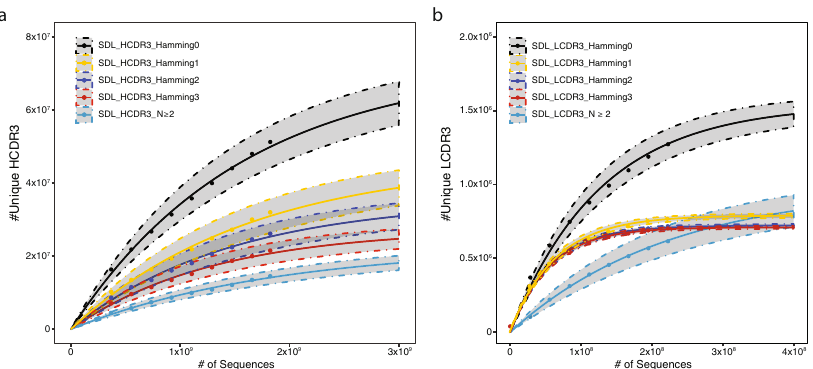
Fig. 2 Heavy and light chain diversity accumulation curves. a Species accumulation curves for HCDR3 at varying hamming distance criteria reveal continued accumulation at all edit string distance cutoffs (Hamming 0 – 3) and using accumulation cutoffs ( N ≥ 2). b Species accumulation curves of light chain CDR3 at varying hamming distance criteria reveal saturation of diversity around 7 – 8 × 10 5 for the combined heavy and light chain for hamming distances 1 – 3 and for abundance cutoffs of N ≥